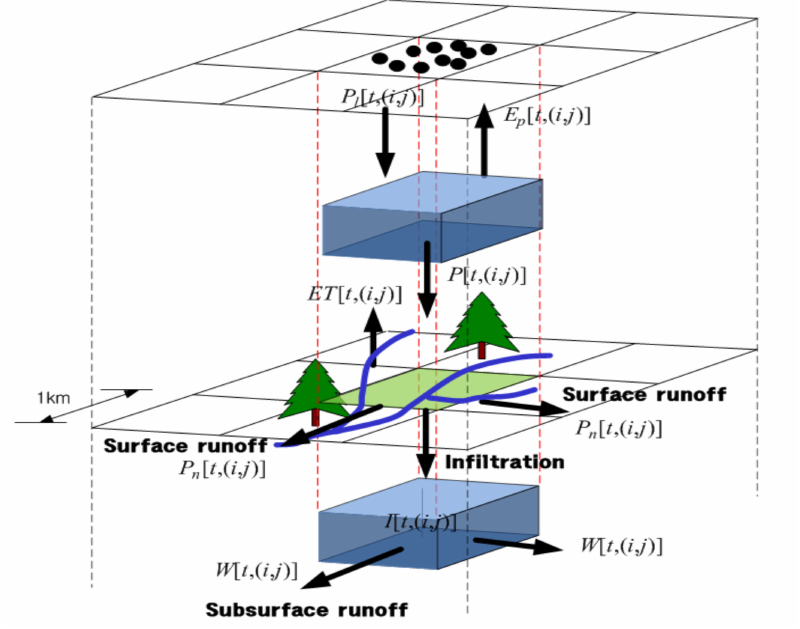
Figure 3. Conceptual Diagram of Grid Water Balace